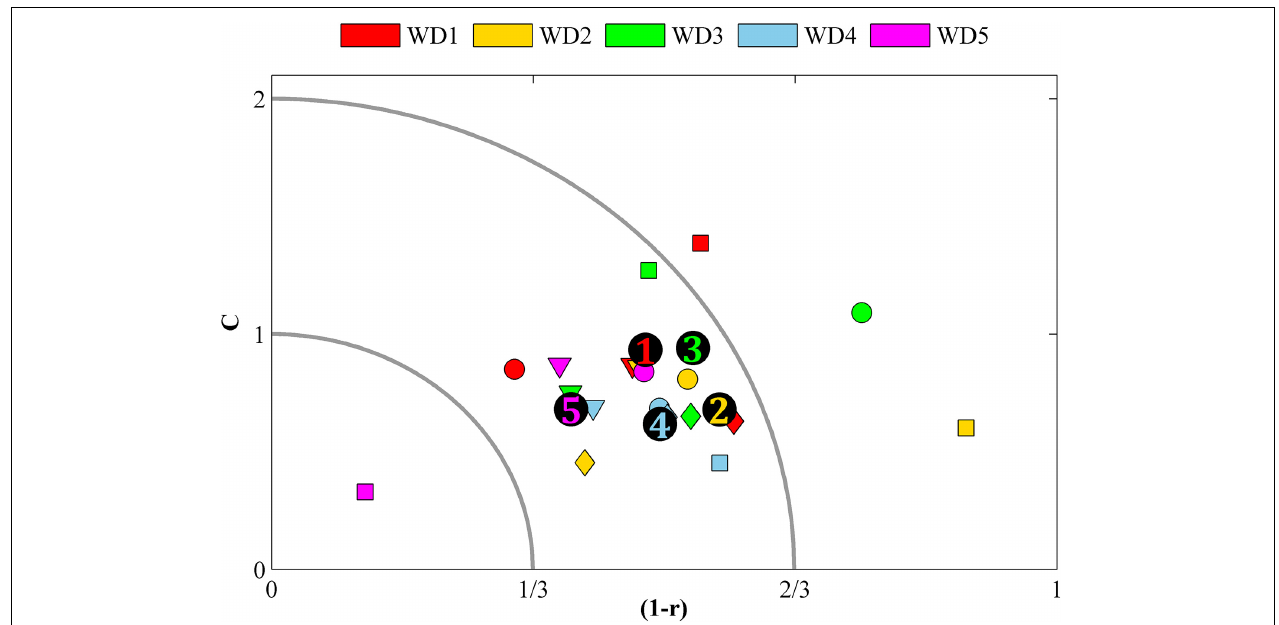
FIGURE 2 | Model bias shown as combination of correlation bias (1– r ) and mean bias C in the five WDs. Colored markers denote the averaged bias for a single variable (square = salinity, round = oxygen, diamond = DIN and triangle = DIP) in a WD. Numbers mark the average bias in a water district (all variables included). Markers inside the outer quarter circle has a combined C and 1– r bias that indicate that the model skill is acceptable and markers within the inner quarter circle indicate good model skill. Markers outside the quarter circles indicate too large